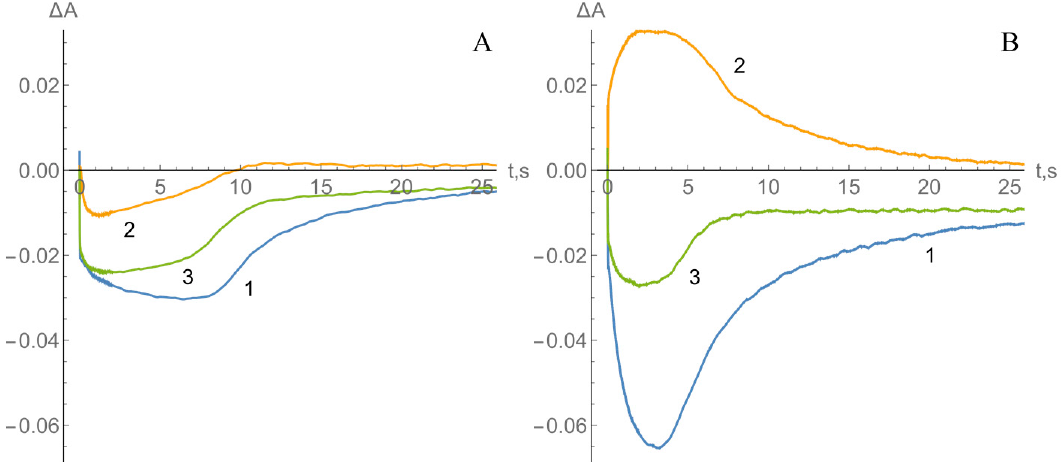
Figure 5. Multiple turnover kinetics of nNOS reduction and reoxidation by O 2 in the presence of NADPH, CAM, H 4 B ( A ) and NADPH, CAM, H 4 B and Arg ( B ). The absorbance changes were followed at 397 nm (1), 436 nm (2). 485 nm (3). Concentrations of nNOS and NADPH after mixing, 2.0 µM and 30 µM.